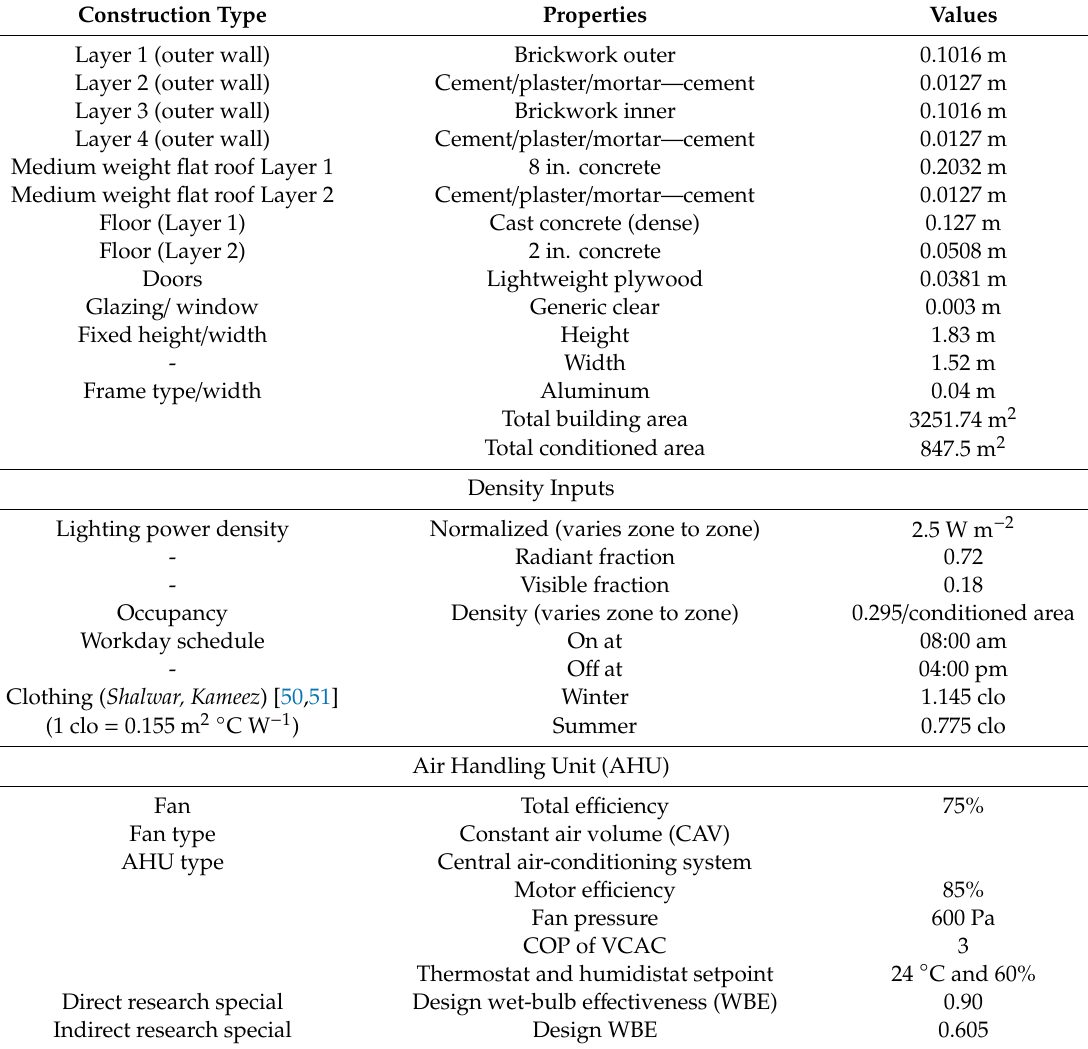
Figure 3. 3-D model for the studied building of the Agricultural Engineering Department of Bahauddin Zakariya University, Multan, Pakistan: ( a ) constructed view, and ( b ) rendered view. Table 1. Simulation inputs and building construction characteristics.